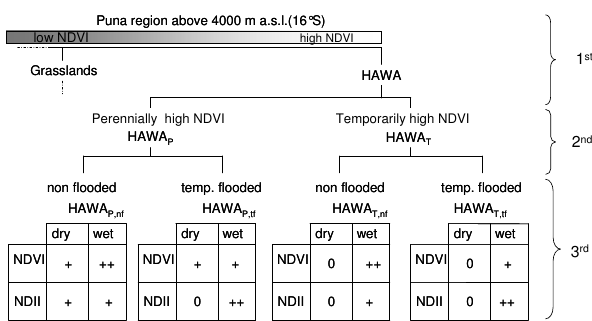
Fig. 5. HAWA mapping design for the use of remote-sensing tech- niques transforming HAWA subtypes into HAWA subclasses. the ground-truth (gt) data based on Landsat ETM+. Within each box plot additionally relative frequency distribution of NDVI values for the entire study region are shown indicat- ing that NDVI range of HAWA ( P 5% – P 95% ) is represented in the flat-tailed part of the distribution (e.g., for Septem- ber 2000: 0.27 NDVI to 0.6 NDVI). HAWA(gt) contained highest NDVI values up to 0.74 and greatest NDVI range in May 2001 (0.31). Minimum NDVI value for HAWA(gt) was below NDVI P 5% of Gra(gt) in May 2001, indicating water saturated conditions or false selected ground-truth grid ele- ments. Figure 6 also depicts that P 5% of B & S(gt), Gra(gt) and Shr(gt) were close together or even slightly